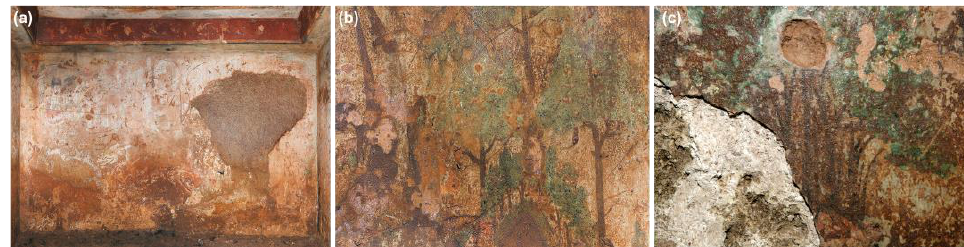
Figure 3. Status of murals in the Jinpari Tomb No. 4. ( a ) West side of burial chamber. ( b , c ) Mural painting details (West side on corridor